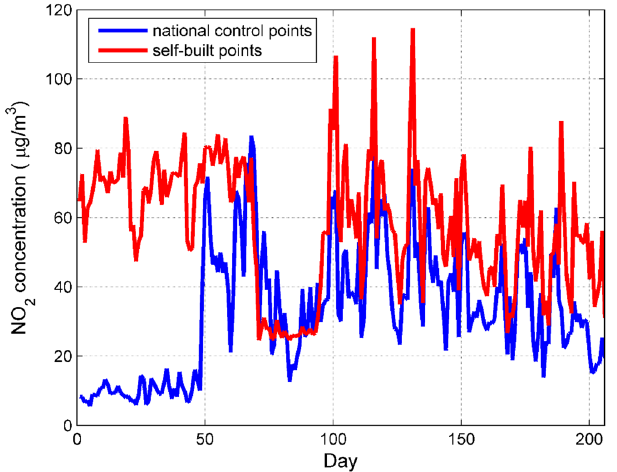
Figure 1. Comparison of daily average NO 2 concentration data between national control points and self-built points. Figures are generated using Matlab (Version R2016a, https ://www.mat- hworks.com/) [Software].